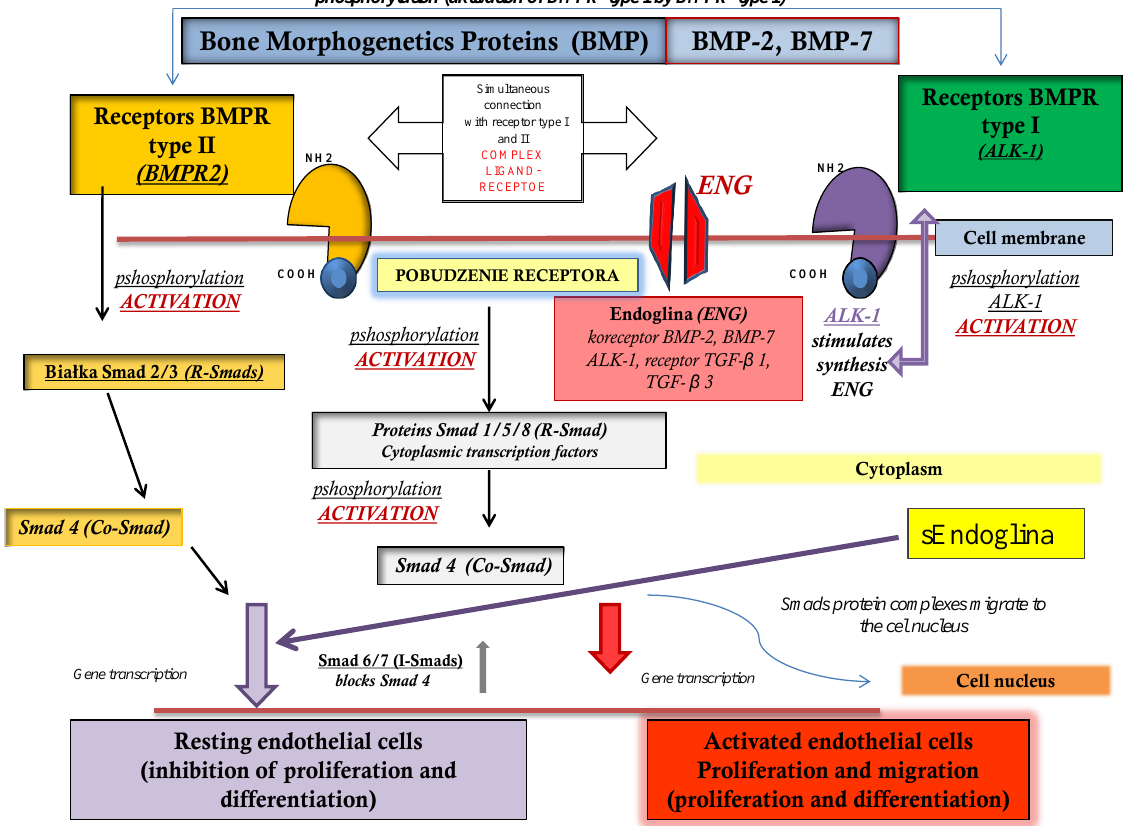
Figure 1. Participation of bone morphogenetic proteins and their receptors in the intercellular signaling pathway.